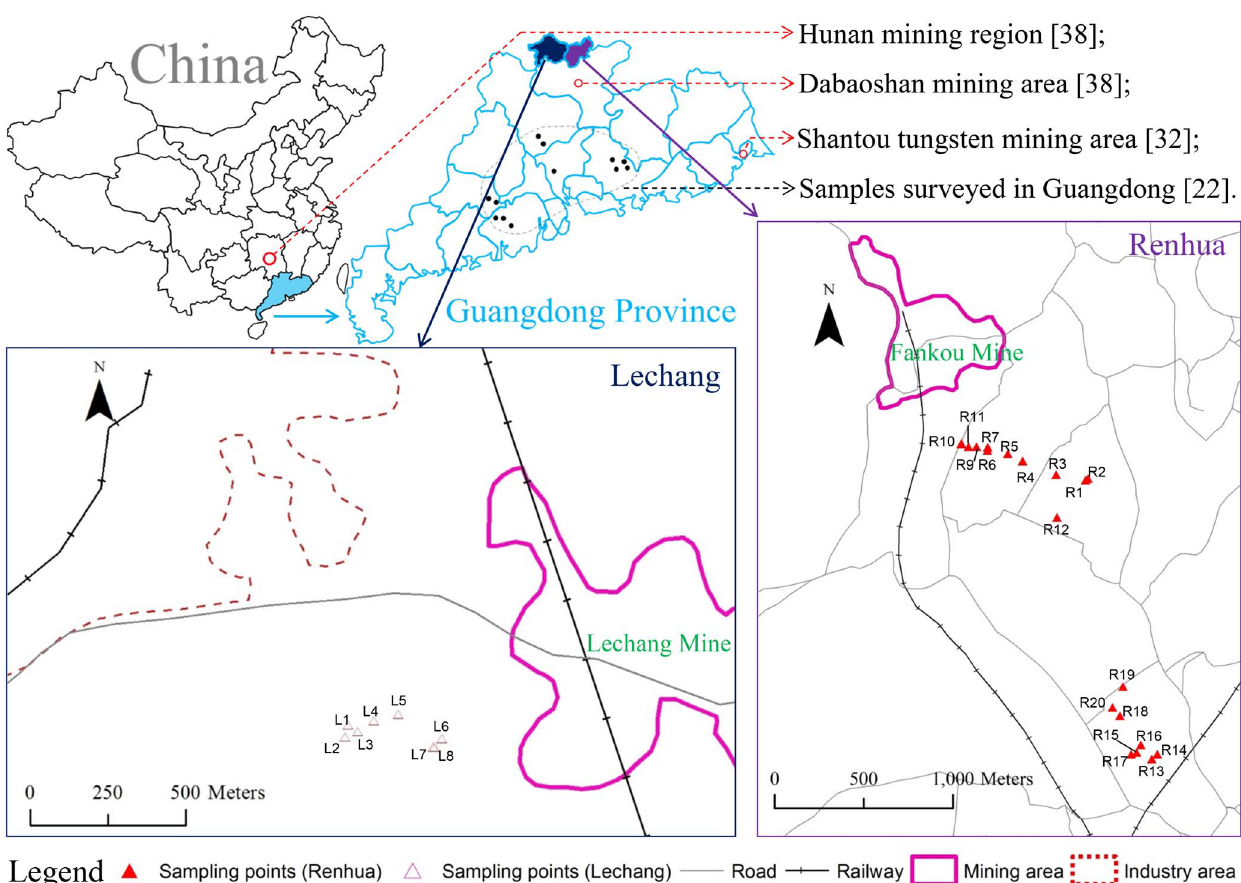
Figure 1. Location map of the study area and distribution of sampling sites.